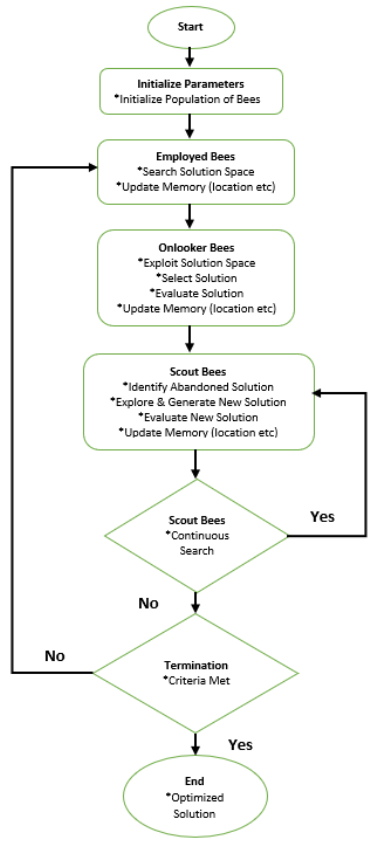
Figure 2. Artificial Bee Colony Algorithm.